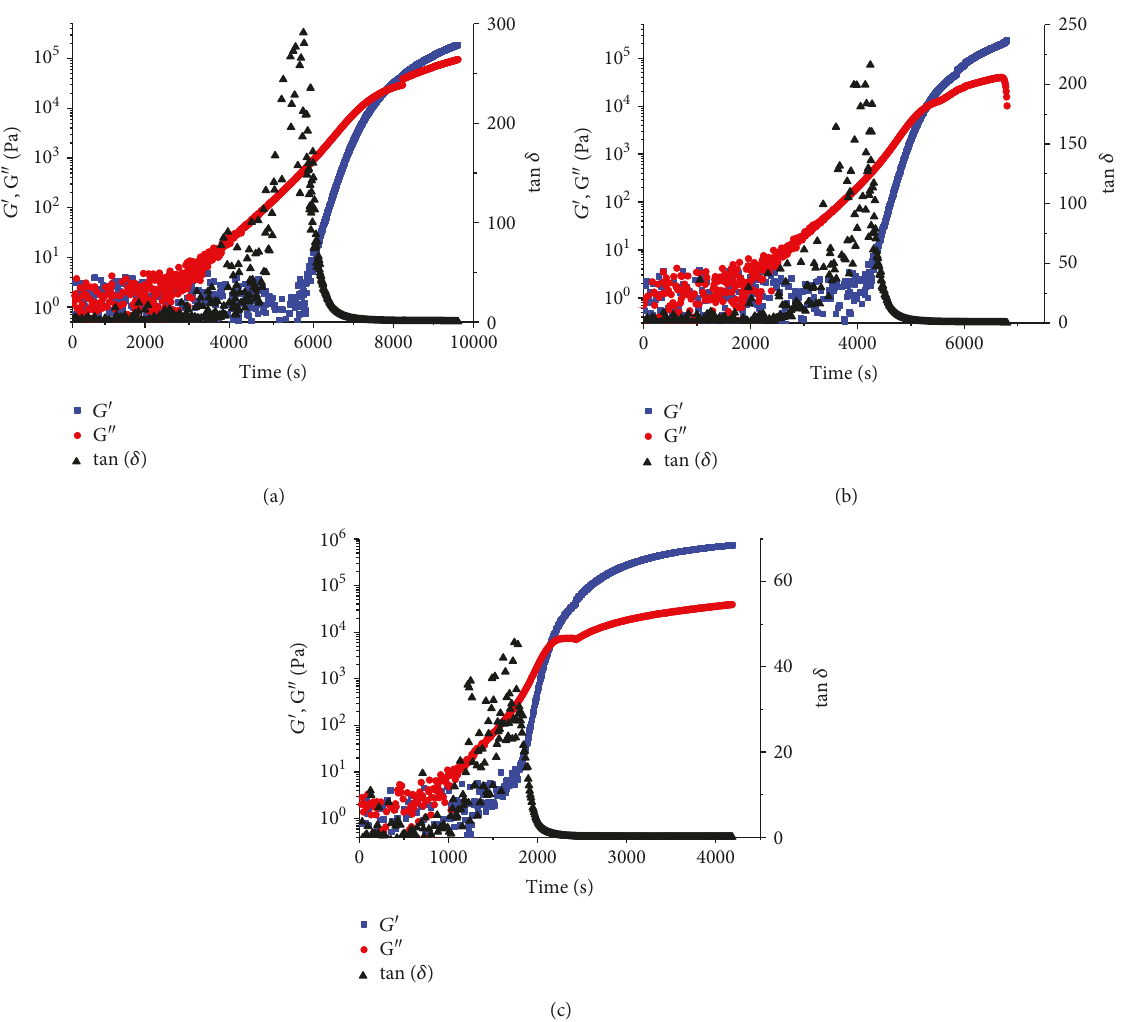
Figure 3: Time sweep for the polythiourethane system at (a) 55 ° C, (b) 65 ° C, and (c) 75 ° C. The frequency ω was set at 6.28rads -1 and the strain was 1%. The changes of G ′ , G ″ , and η ∗ with time were